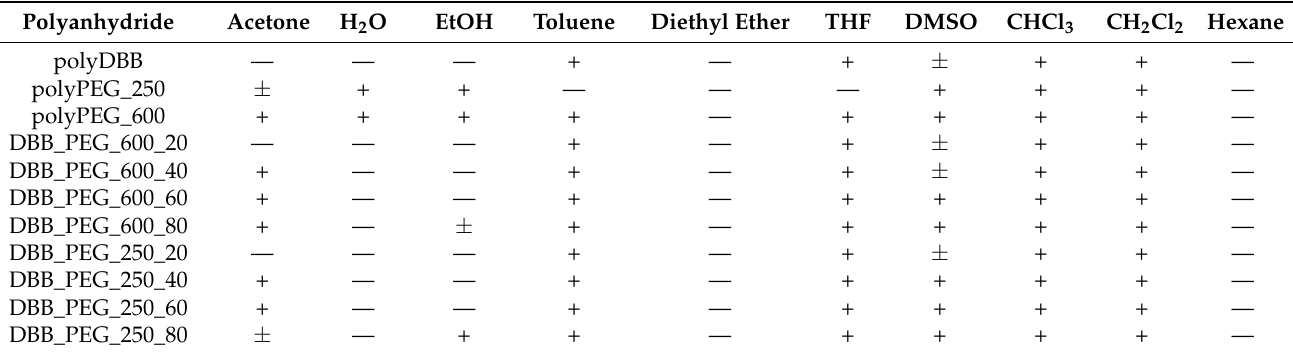
Table 2. Solubilities of